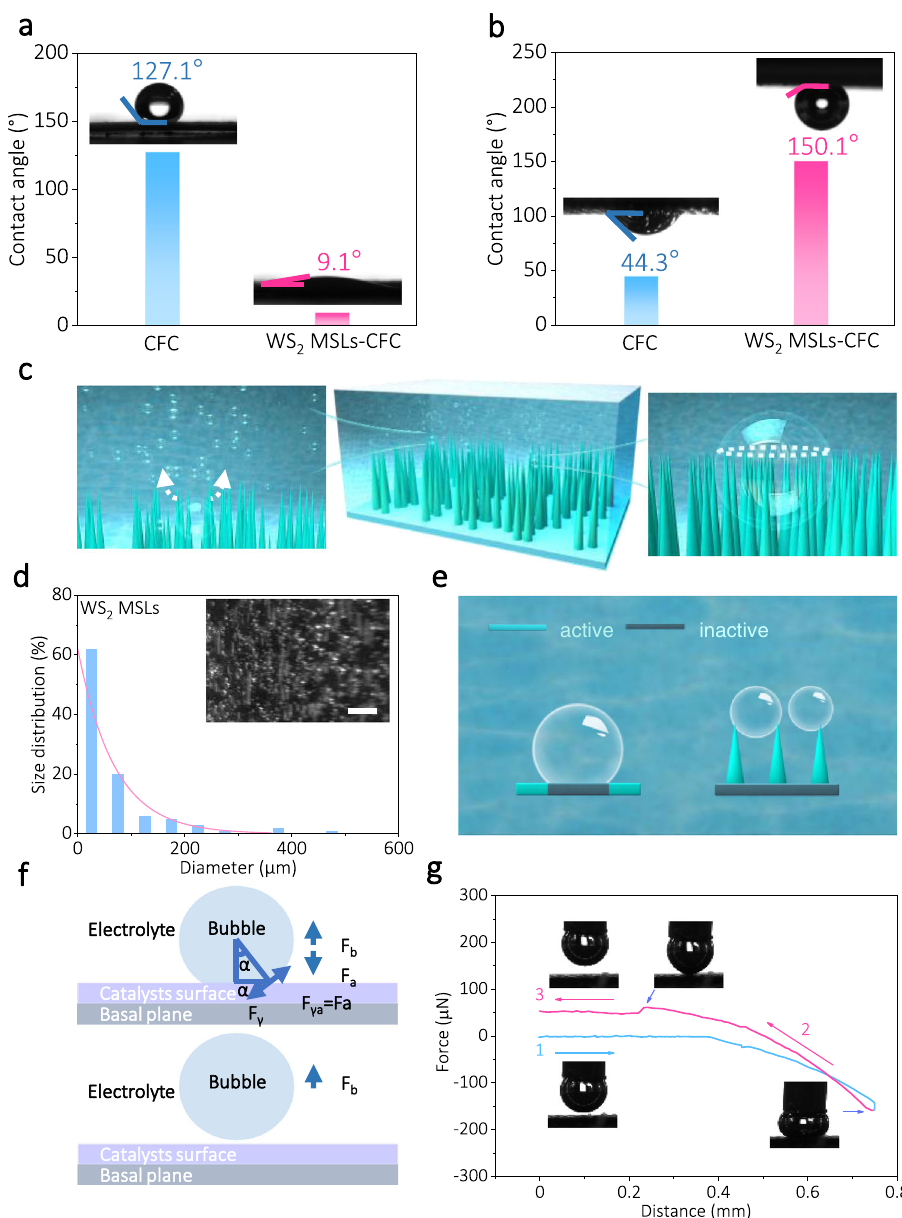
Fig. 4 Mass transfer behavior research. a Contact angles of an electrolyte droplet on the catalysts ’ surfaces. b Contact angles of a gas bubble on the catalyst surface under electrolyte. c Schematic illustration of how the conical nanoarrays surface morphology is affecting the bubble contacts and release. d Size distributions statistics of releasing bubbles on the surfaces of a WS 2 MSLs electrode, and (inert) digital photo is demonstrating the bubble releasing behaviors on the surface of WS 2 MSLs for HER. Scale bars, 1.0 mm. e Schematic illustration of bubble and catalysts contact. f Stress analysis of one single bubble on the surface of the catalyst. g Adhesive forces measurements of the gas bubbles on WS 2 MSLs – CFC Fig. 5. The atomic structure can fi ne-tune the electronic structure of the active sites by upshifting the d band center of W atoms and p band center of S atoms, which indicates the same trend of the enhanced hydrogen binding energy, thus promoting the HER performance (Supplementary Fig. 36c and Supplementary Fig. 38c). Accordingly, we evaluated the HER activity of 2H-WS 2 MSLs and 1T ’ -WS 2 MSLs using DFT by comparing Δ G H for Fig. 39). The Δ G H close to zero at 1T ’ -WS 2 MSLs basal plane site ( − 0.24 eV) validates the HER activity of WS 2 MSLs relating to the base plane in this study. Therefore, the enhanced HER activity can be ascribed to the synergistic effect of phase and MSLs.